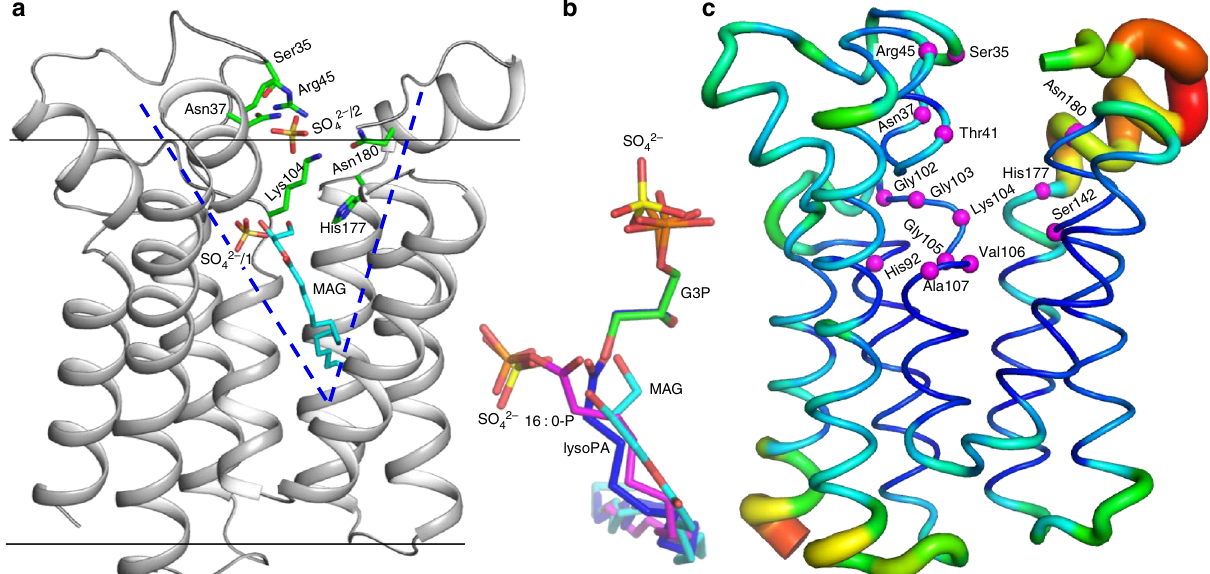
Fig. 3 The active site of aa PlsY. a The V-shaped active site hosting a MAG molecule and two SO 4 2- ions. Active site residues from a previous report 12 , the MAG, and the two sulphates were shown in sticks. b Superimposition of all active site ligands. The MAG, 16:0-P, G3P, and lysoPA are shown in stick representations with the oxygen atoms in red, sulphur atoms in yellow, and carbon atoms in cyan, magenta, green, and blue, respectively. c Putty representation of B-factors of the aa PlsY MAG structure. Blue lines and red tubes indicate low and high B-factors, respectively. The C α atoms of active site residues are highlighted as magenta